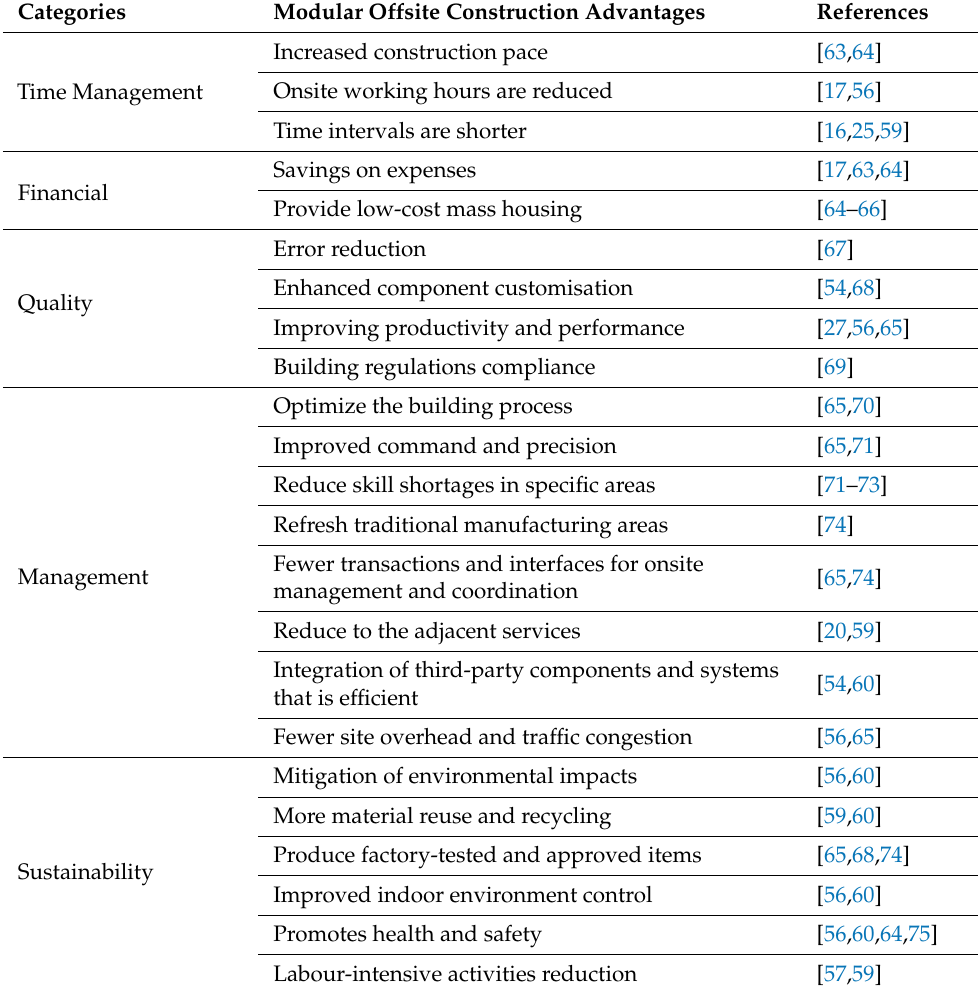
Table 1. Modular Offsite Construction